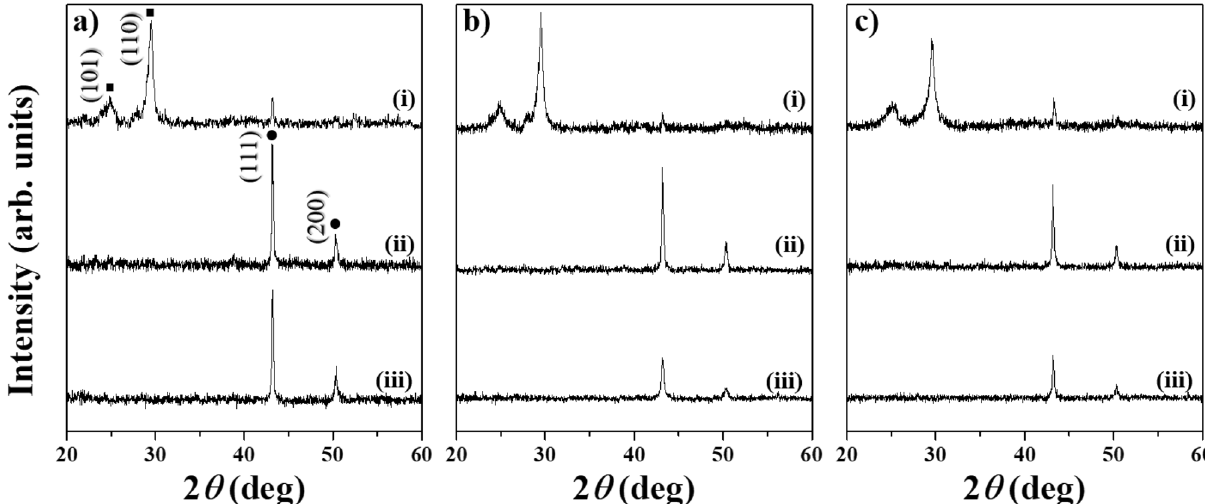
Figure 2. XRD patterns of samples synthesized by PLAL of a Cu plate in (i) acetonitrile, (ii) propionitrile, and (iii) butyronitrile at different laser wavelengths of ( a ) 355, ( b ) 532, and ( c ) 1064 nm. Characteristic peaks